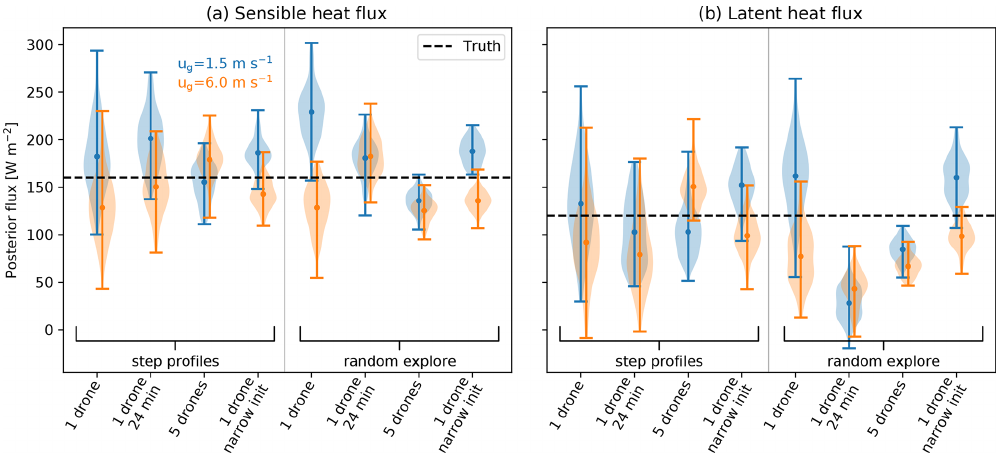
Figure 4. Assessment of observation strategies from synthetic experiments with true H = 160Wm − 2 and LE = 120Wm − 2 . Violins show the kernel-density-estimated posterior distributions of surface sensible (a) and latent (b) heat fluxes obtained by the ES-MDA method with two iterations. The caps of the violins mark the extrema of the ensemble, and the dots mark the mean values. Colors denote two different wind speeds u g . The experiment with one drone flying a step profile corresponds to the case shown in Fig. 3. Flight plans for the different observation strategies are shown in Fig. S2 in the